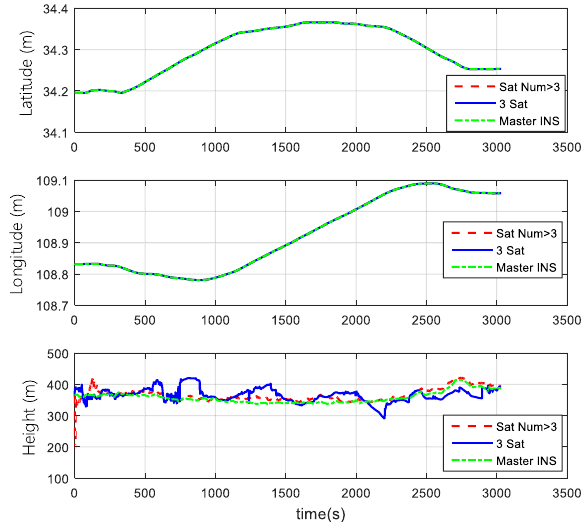
Figure 13. Position comparison of navigation by normal number of satellites and 3 satellites.